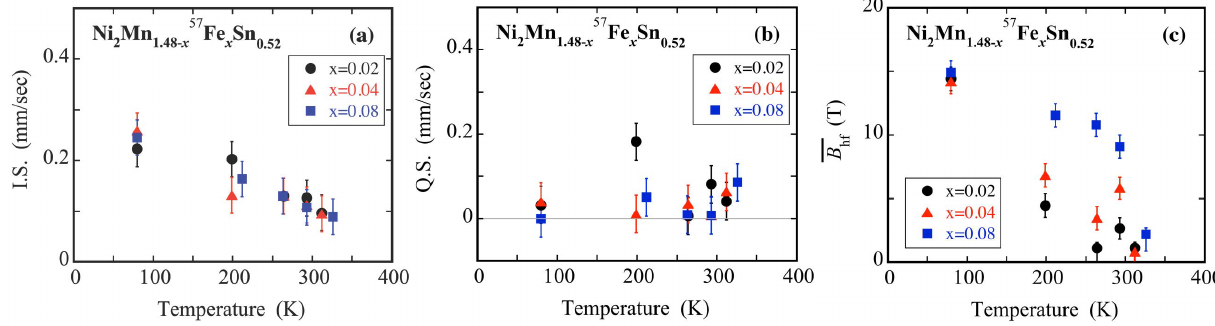
Figure 6. Temperature dependences of the isomer shift, I.S., the quadrupole splitting, Q.S., and the absolute average 57 Fe hyperfine field, B , obtained from the fitting in Figures hf